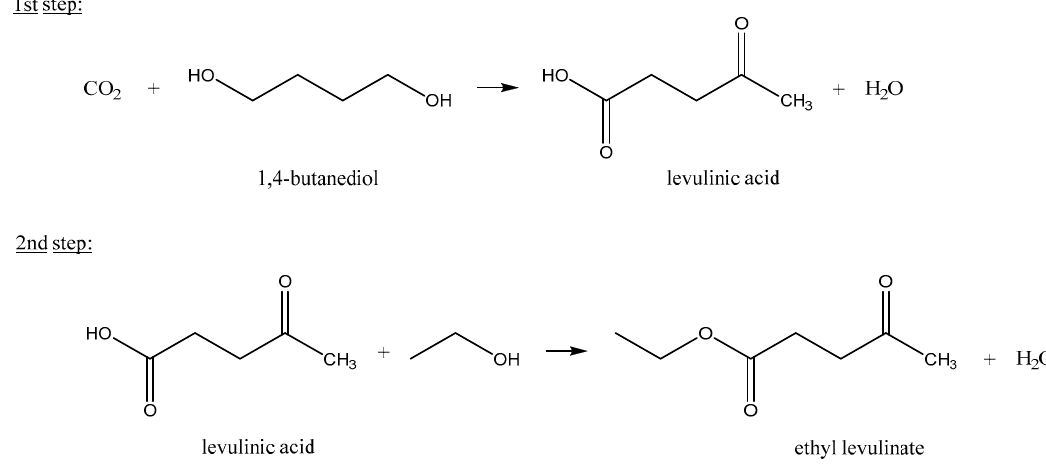
Figure 1. The two-step synthesis of ethyl levulinate from carbon dioxide and Figure 1 . The two-step synthesis of ethyl levulinate from carbon dioxide and 1,4-butanediol.